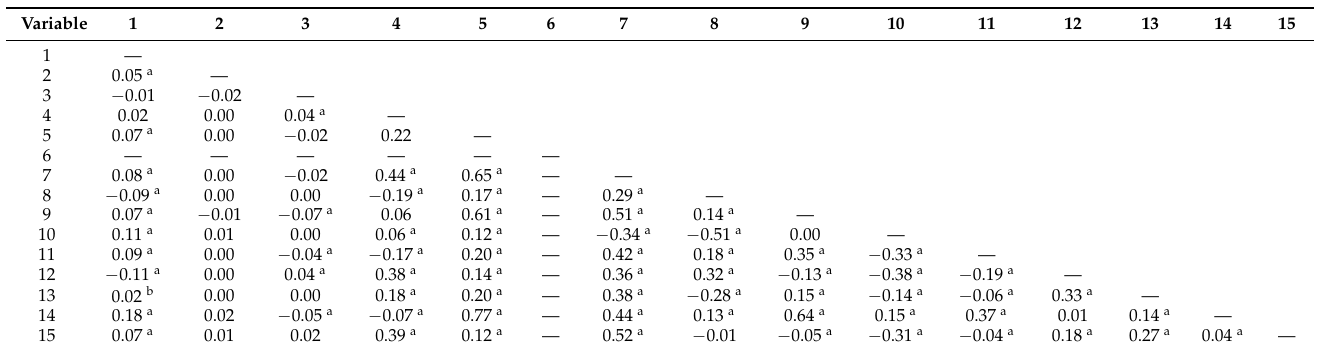
Table 7. Correlation of measured speed with road factors (60 mph PSL).